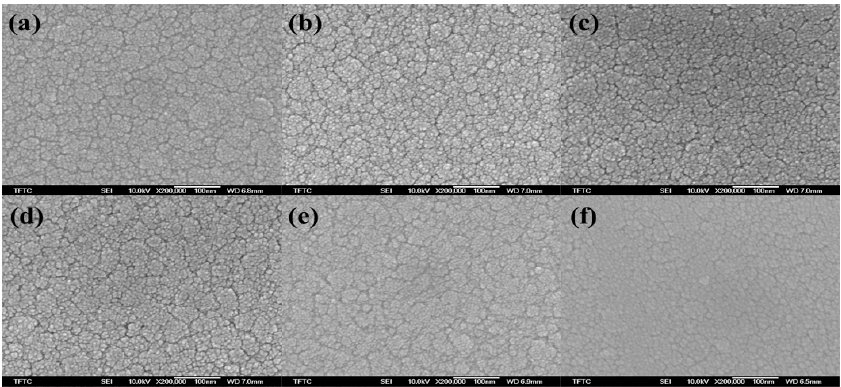
Figure 3. SEM morphologies for ( a ) WO 3 , ( b ) W-Nb-150w, ( c ) W-Nb-250w, ( d ) W-Nb-350w, ( e ) W- Figure Nb-450w, and ( f ) Nb 2 O 5 films.